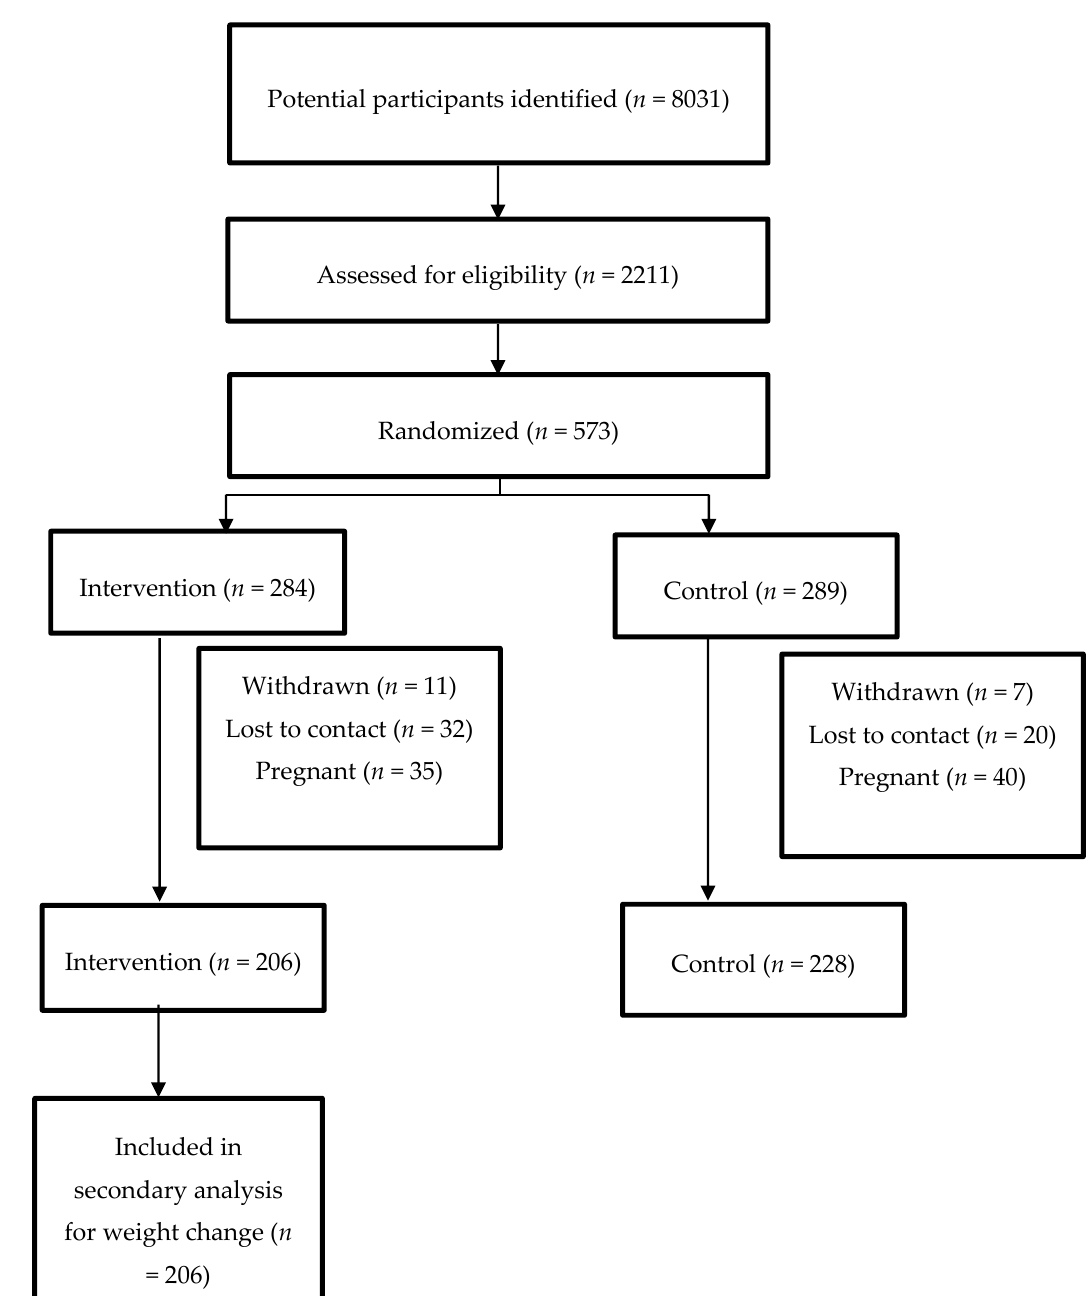
Figure 1. The flow of participants for the secondary analysis of the Mothers After Gestational Diabetes (MAGDA) study.